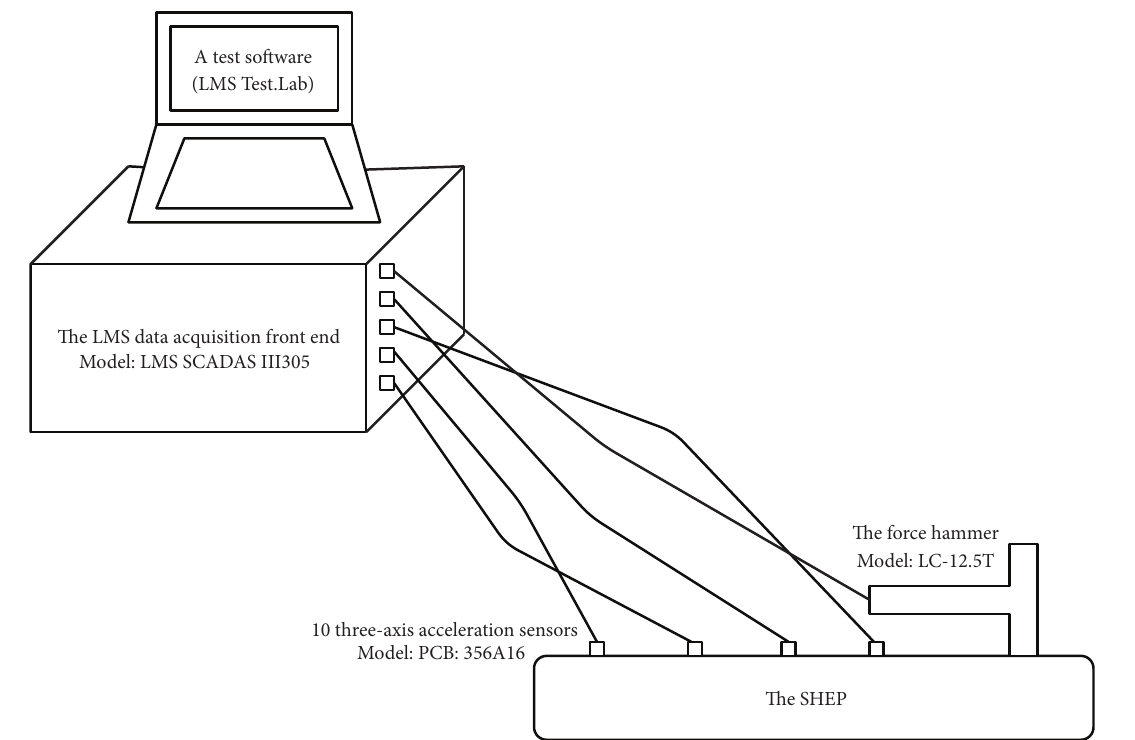
Figure 11: The block diagram of the LMS modal test system of the SHEP.